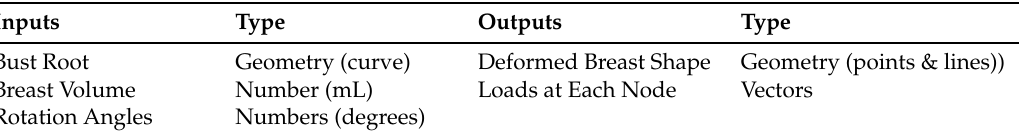
Table 3. Breast simulation inputs and